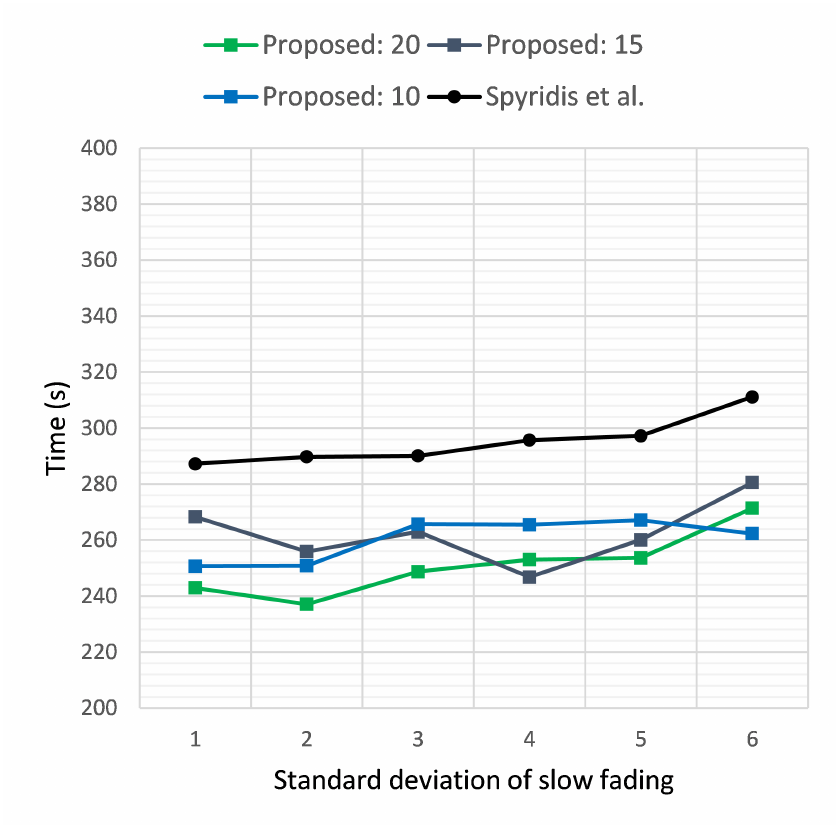
Figure 5. Time required for the first UAV to reach the target sensor when placed at a distance of 2 km, versus the standard deviation σ of the additive noise. Comparison of the proposed method at clustering termination thresholds of 20, 15 and 10 dB and the previous